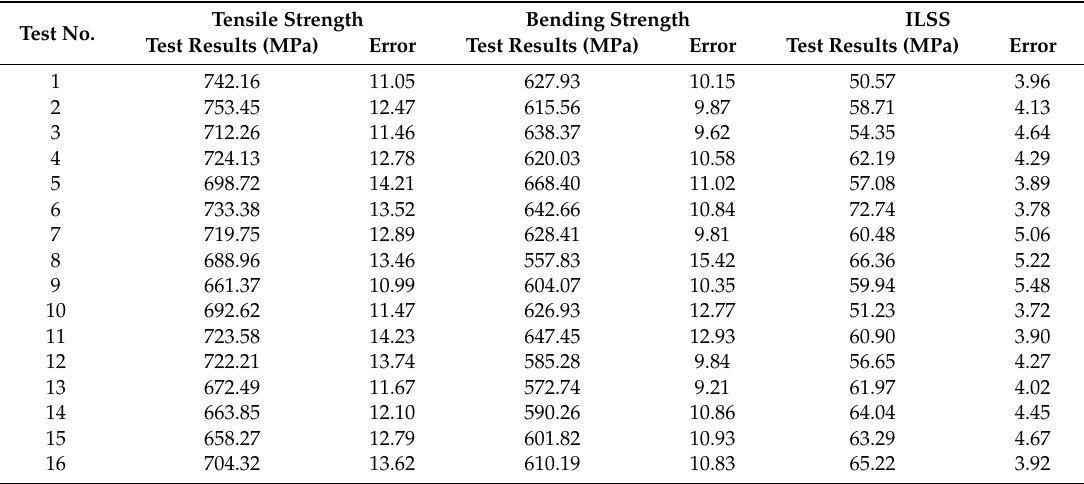
Table 4. The results of L 16 (4 5 ) orthogonal